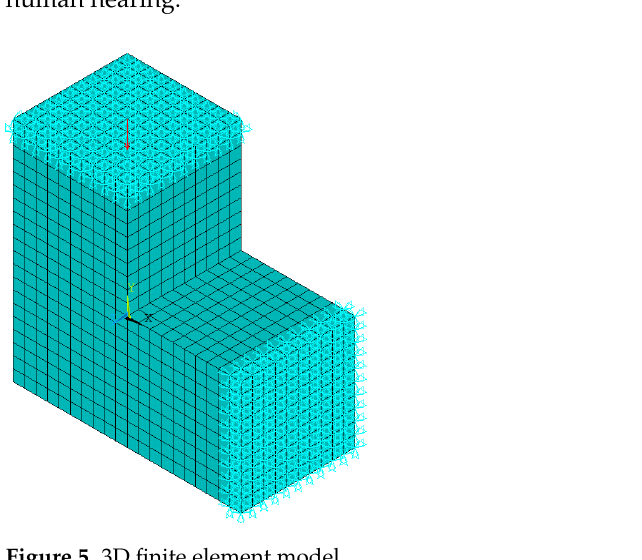
Figure 5. 3D finite element model.